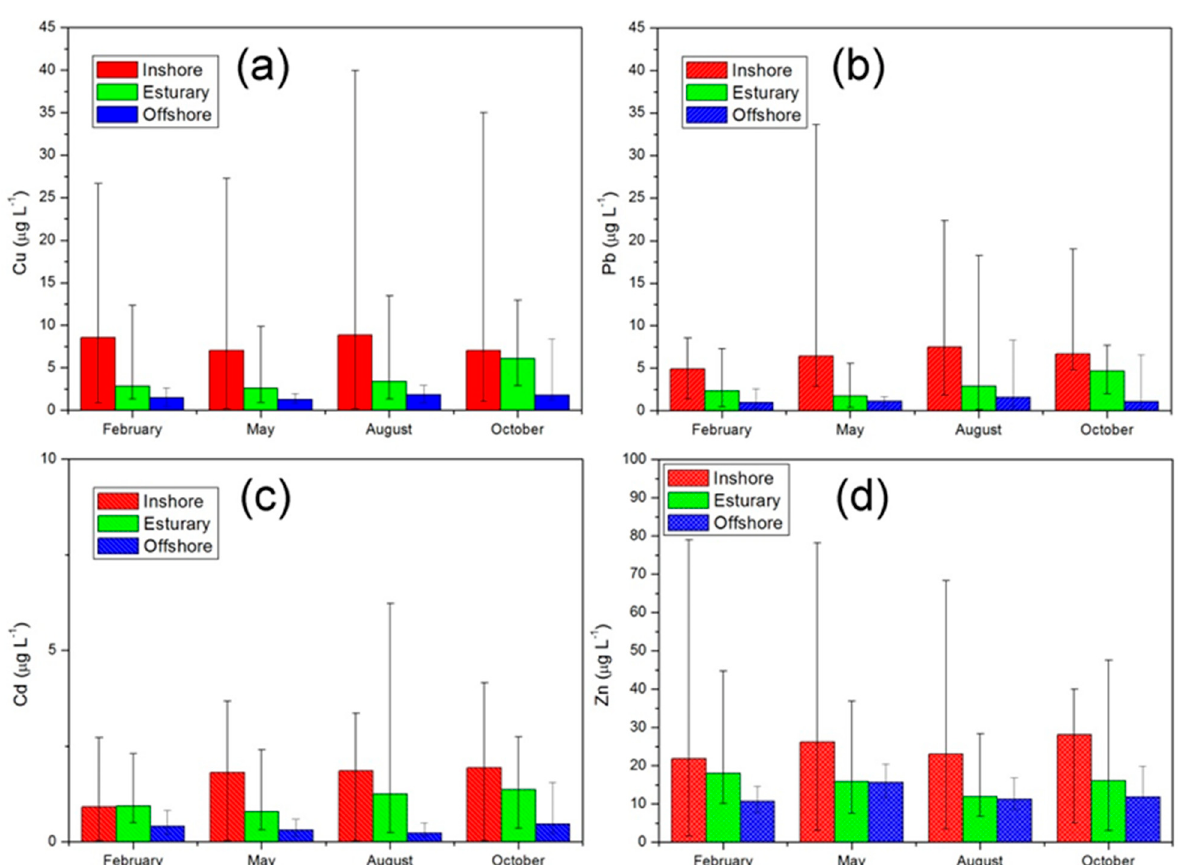
Figure 3. Seasonal and regional variations in Cu, Pb, Cd and Zn in seawater. Error bars indicate standard errors. ( a ) Cu; ( b ) Pb; ( c ) Cd; ( d ) Zn.